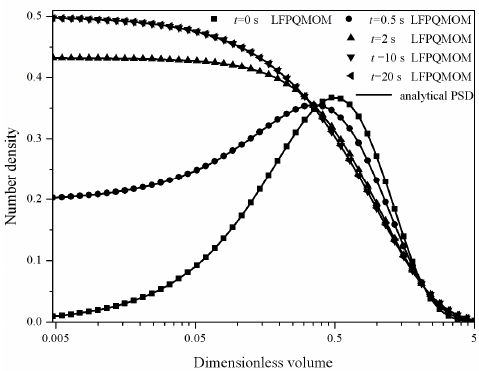
Figure 22. Particle size distributions at 0, 0.5, 2, 10, and 20 s for the aggregation and breakage combined process with constant aggregation kernel, linear breakage kernel, uniform daughter distribution, and Gaussian initial particle size distribution (square: numerical PSD at 0 s; circle: numerical PSD at 0.5 s; up triangle: numerical PSD at 2 s; down triangle: numerical PSD at 10 s; left triangle: numerical PSD at 20 s; line: analytical PSDs).